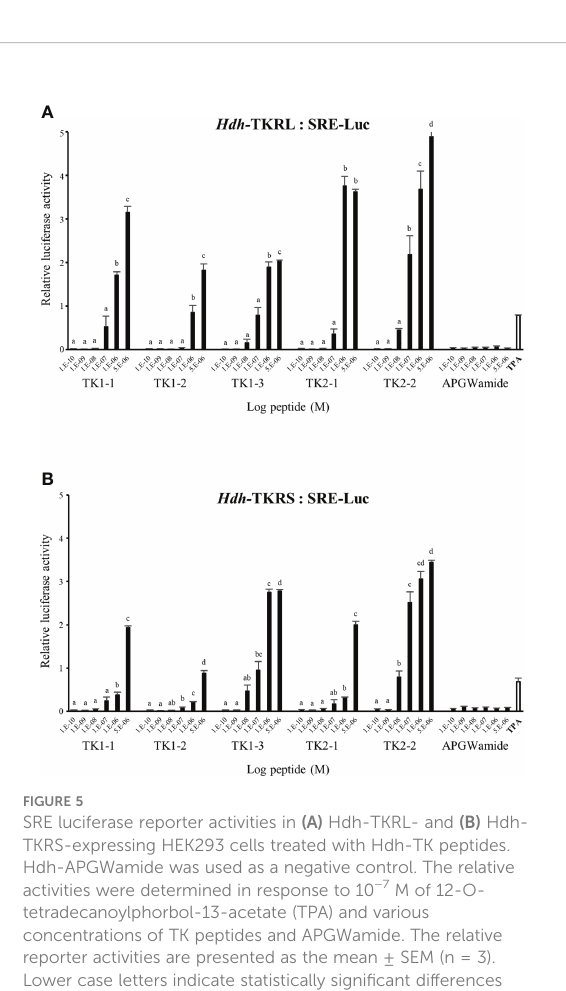
FIGURE 5 SRE luciferase reporter activities in (A) Hdh-TKRL- and (B) Hdh- TKRS-expressing HEK293 cells treated with Hdh-TK peptides. Hdh-APGWamide was used as a negative control. The relative activities were determined in response to 10 − 7 M of 12-O- tetradecanoylphorbol-13-acetate (TPA) and various concentrations of TK peptides and APGWamide. The relative reporter activities are presented as the mean ± SEM (n = 3). Lower case letters indicate statistically signi fi cant differences (p <